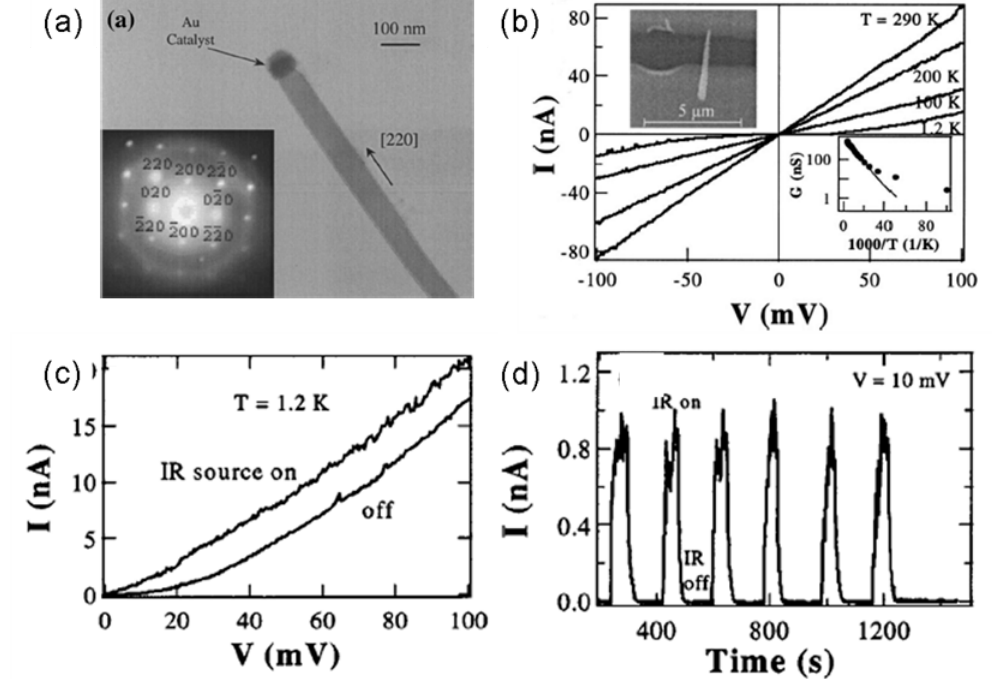
Figure 9. (a) TEM image and SAED pattern of a CdO nanoneedle; (b) Temperature- dependent I-V curves recorded with the temperature ranging from 290 K to 1.2 K; (c) I-V curves measured at 1.2 K with the IR light source on and off, respectively; (d) Real-time measurement of IR response of the nanoneedle device. Reproduced from